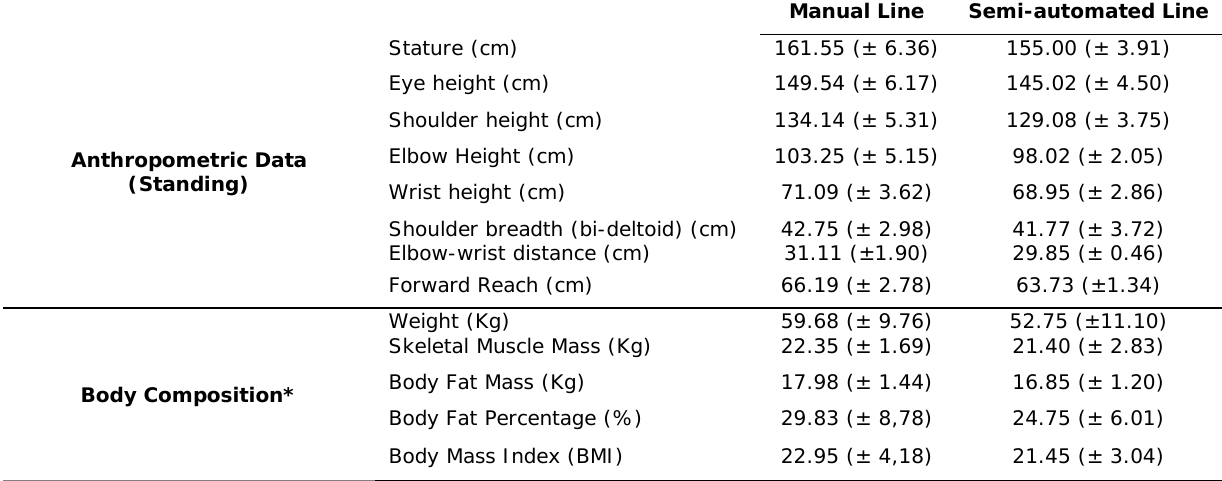
Table 2. Anthropometric data and body composition of the